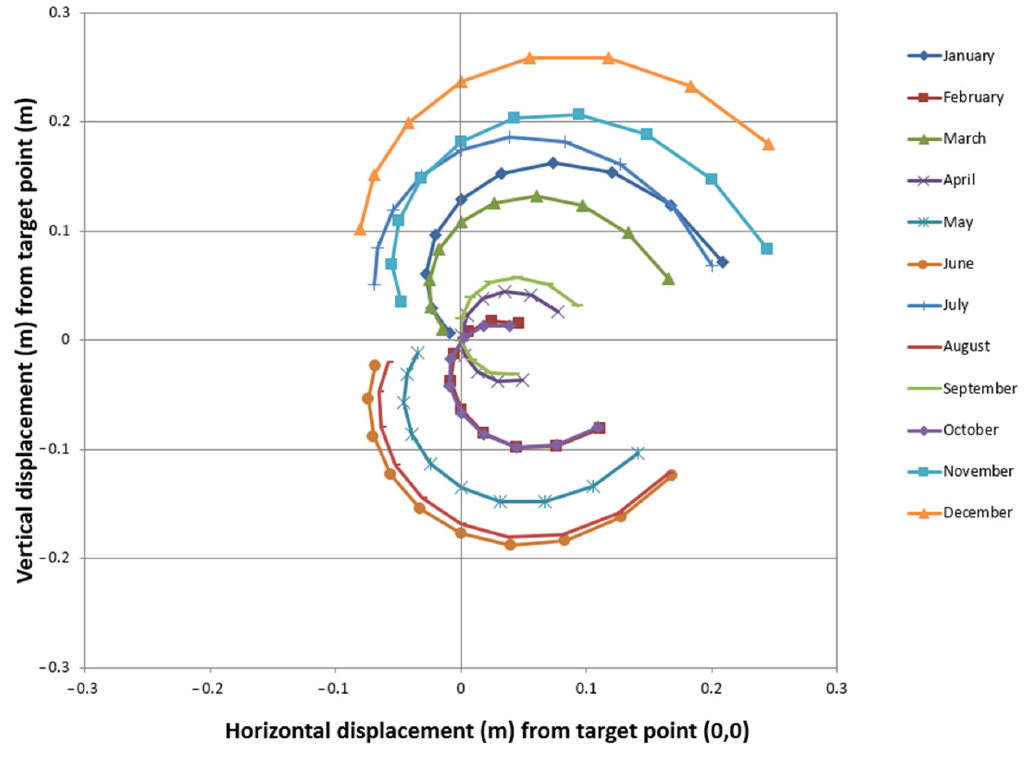
Figure 15. Monthly representation of pointing error ξ .